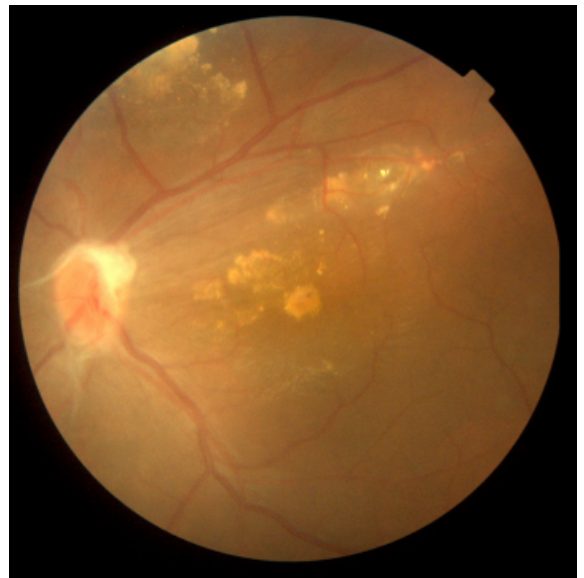
Figure 3: Subretinal old refractile exudation at macula was seen as well as premacular and optic disc fibrous proliferation with macular dragging.